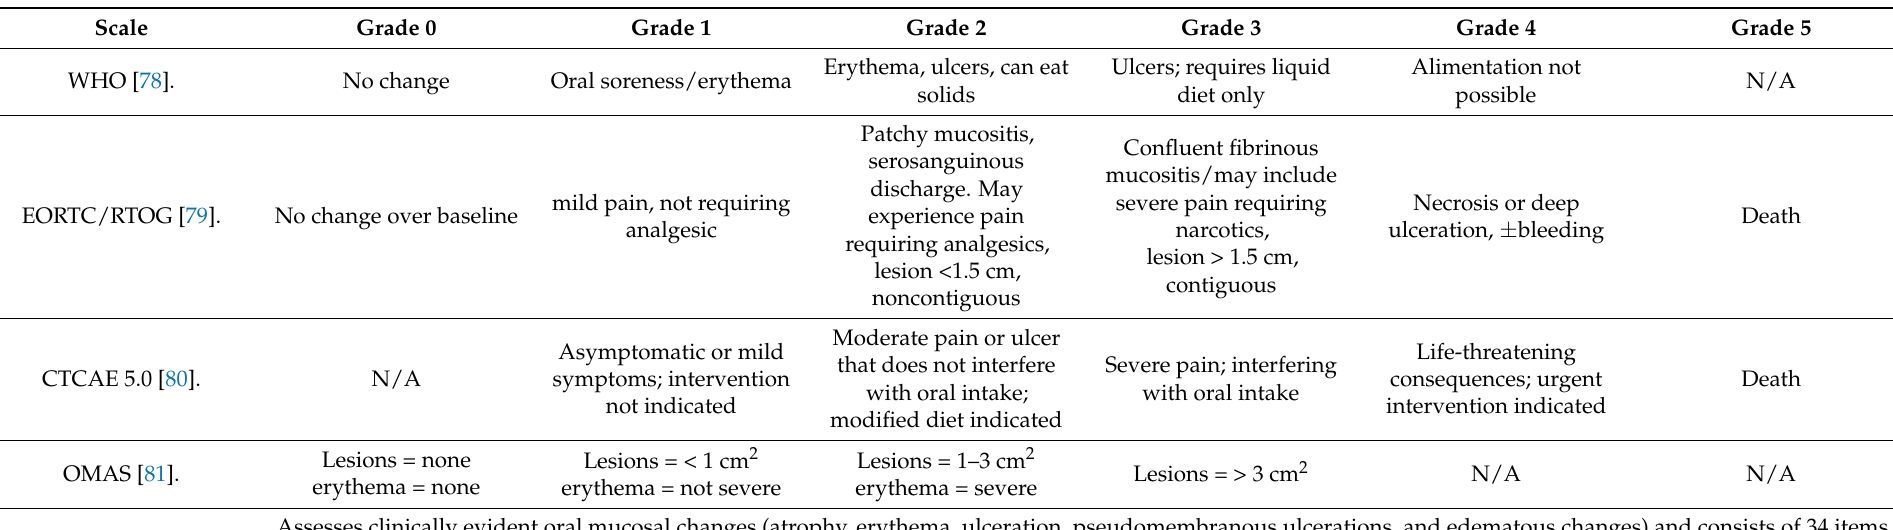
Table 6. Comparison of description of radiation-induced oral mucositis